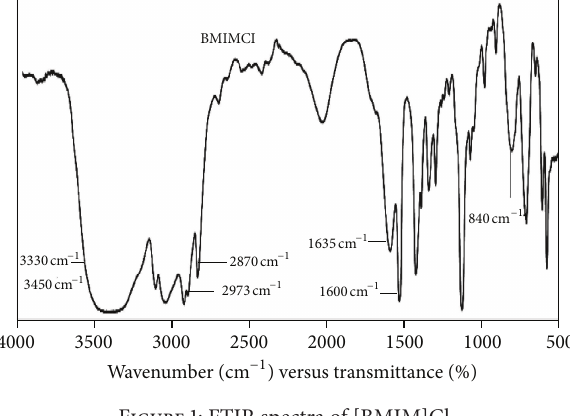
Figure 1: FTIR spectra of [BMIM]Cl.